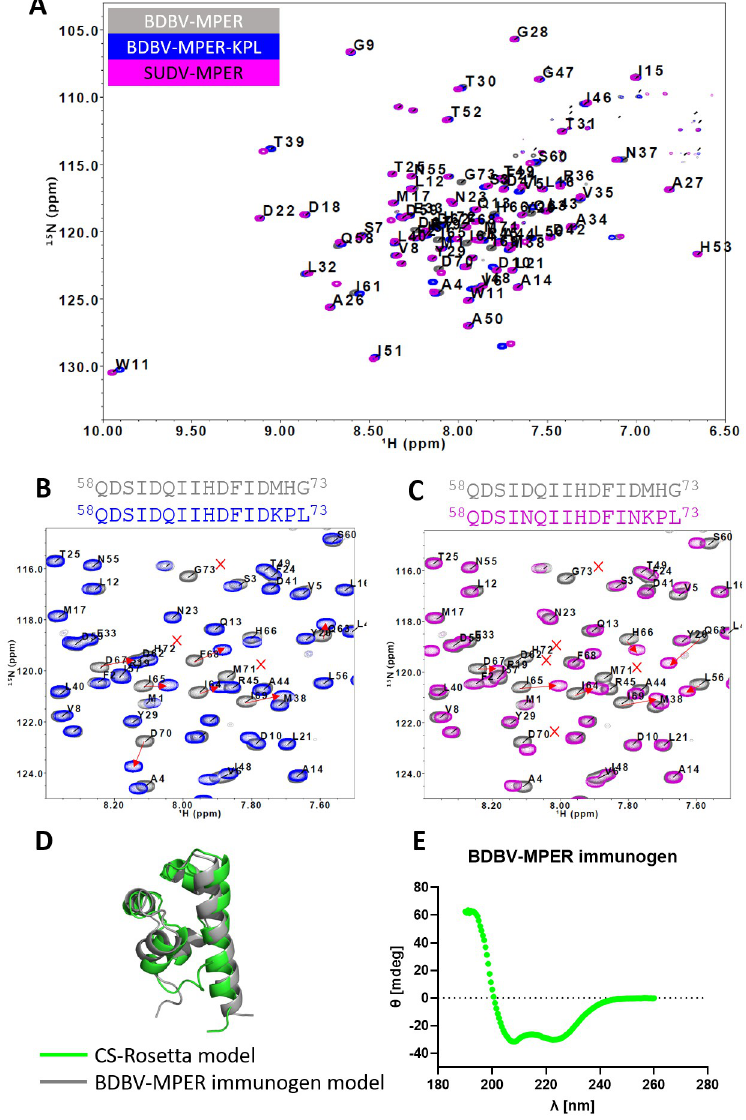
Fig 7. Structural validation of the BDBV-MPER immunogen design using solution NMR. (A) 1 H- 15 N TROSY spectra of BDBV-MPER, BDBV-MPER-KPL, and SUDV-MPER immunogens. Backbone resonance assignments are indicated by one-letter amino acid code and sequence number. Resonances that are unassigned correspond to the purification tags. (B) Overlay of 1 H- 15 N-TROSY spectra of BDBV-MPER and BDBV-MPER-KPL immunogens. The only change in the protein sequence is 71 MHG 73 to 71 KPL 73 meaning that there are no corresponding peaks for residues 71–73. Red arrows indicate shifted peaks. (C) Close-up view of the BDBV-MPER, BDBV-MPER-KPL and SUDV-MPER immunogen 1 H- 15 N-TROSY spectra with the BDBV-MPER backbone assignment. (D) The NMR- derived model of BDBV-MPER in green is overlaid with the Rosetta-designed BDBV-MPER immunogen in grey. The backbone RMSD between the experimental and predicted structure was 2.4 Å . (E) CD spectrum of the BDBV-MPER immunogen.